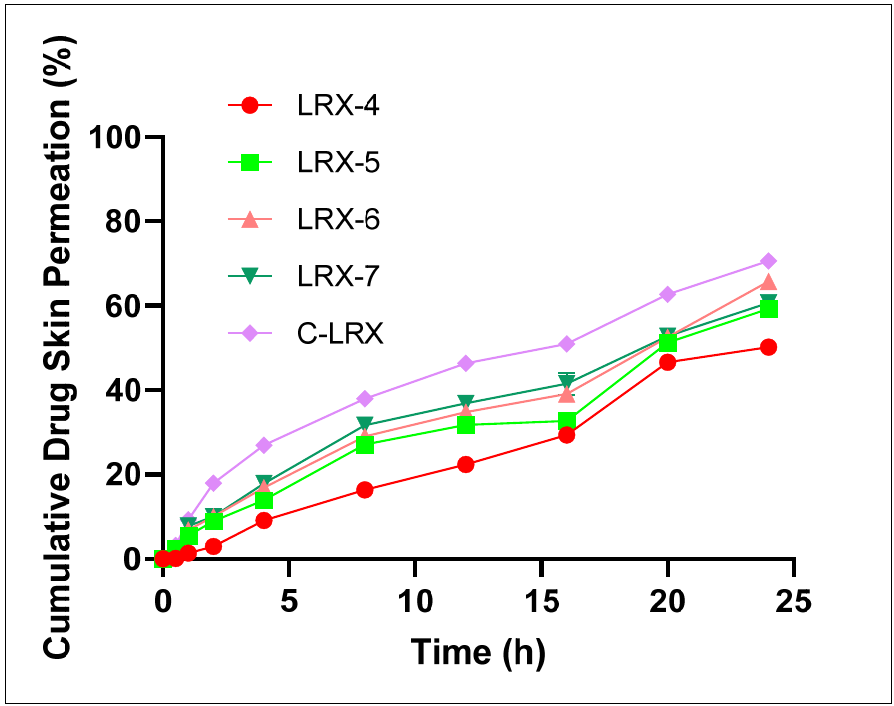
Figure 7. Percent cumulative drug skin permeation of selected LRX formulations.